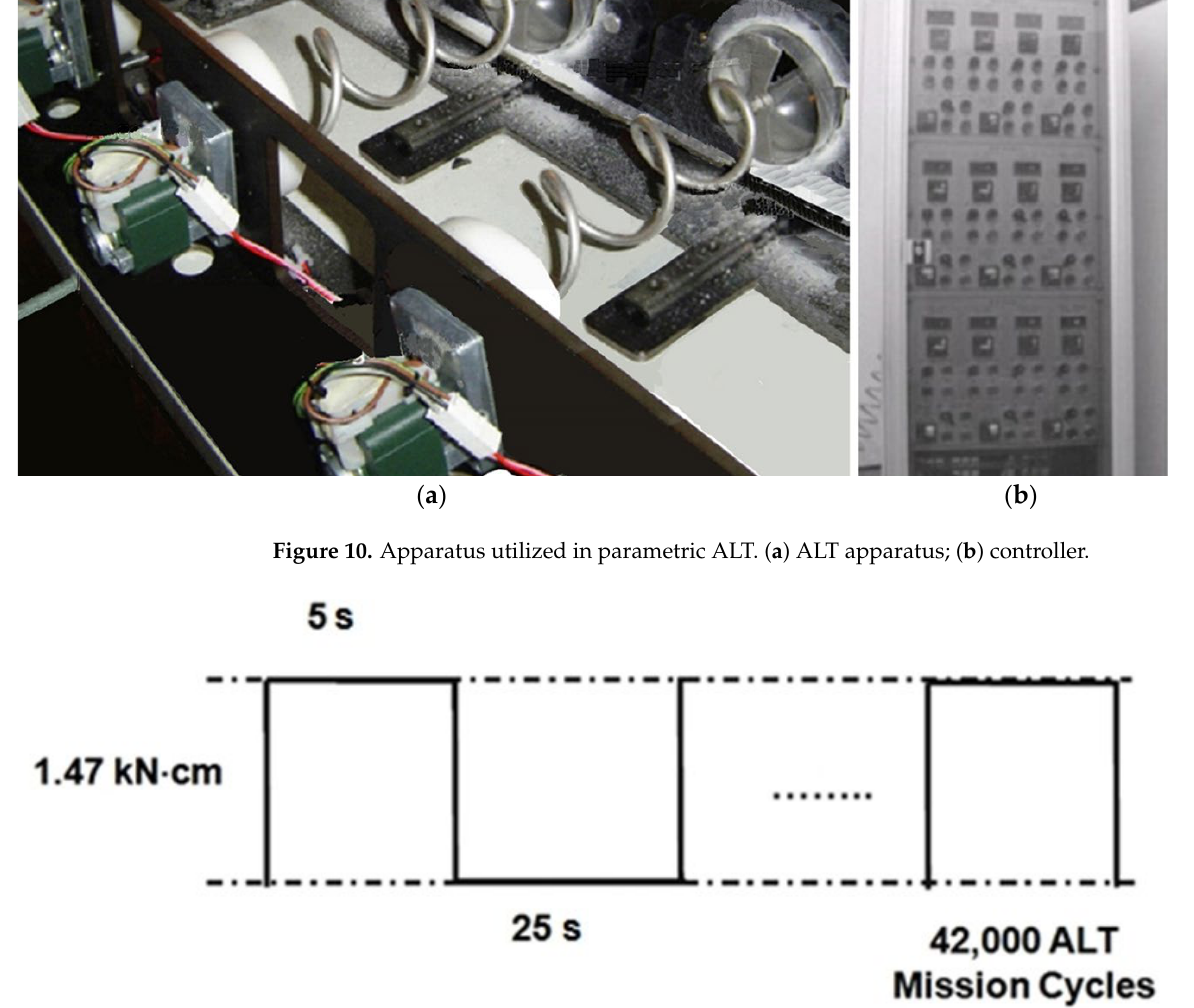
Figure 11. Duty cycles of the ice-crushing torque T L applied on the band clamper.